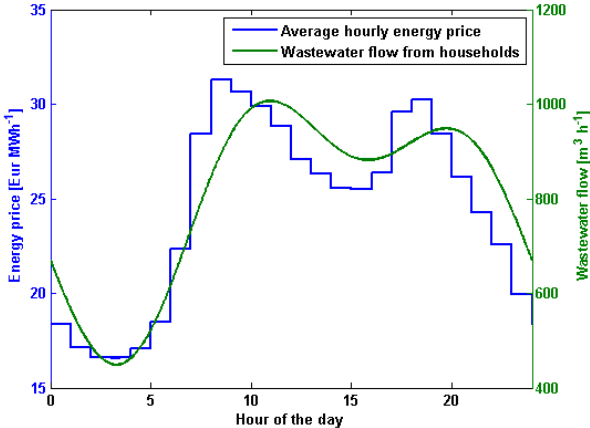
Figure 1. Yearly average (2015) of hourly energy price for the en- ergy market DK2 covering the Copenhagen region (in blue, data from http://www.nordpoolspot.com/). Calibrated daily variation of the dry weather flow for the Damhuså catchment (green) used for demonstration in this paper; see further details in Sect.